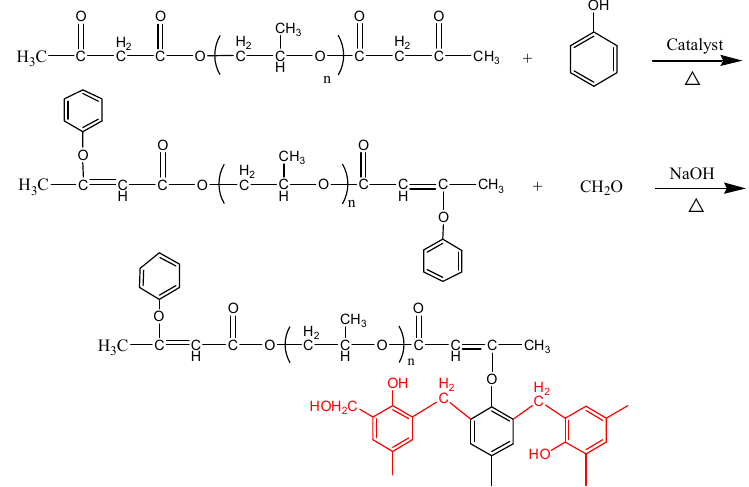
Table 1. The polyether phenolic resin synthesis formula.